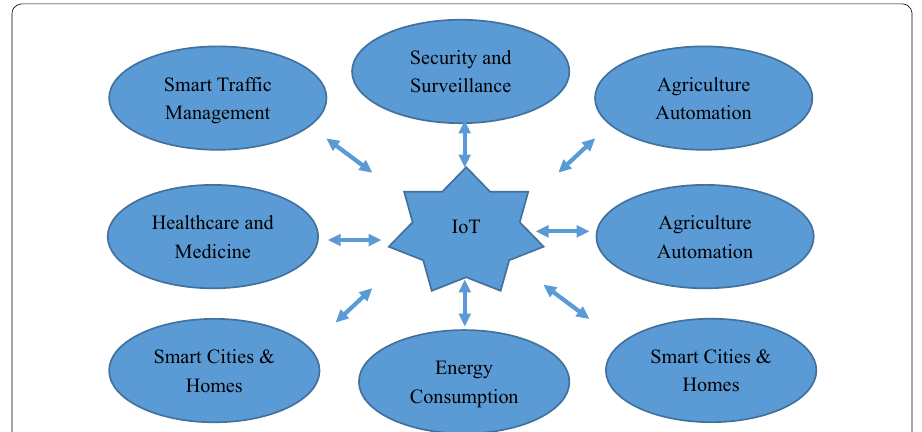
Fig. 2 Some of the potential application domains of